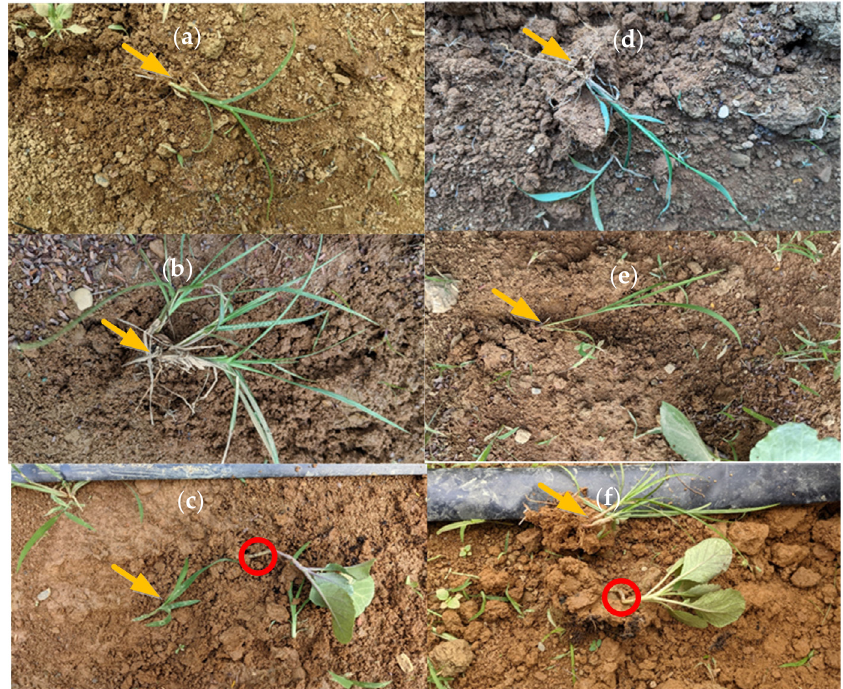
Figure 11. Snapshot of the soil on the field after weeding by the weeding machine. ( a ) weeds are completely removed by weeder #2, partially removed ( b ) and damaged crops ( c ); ( d ) weeds are completely removed by weeding tool #1, partially removed ( e ) and damaged crop ( f ). The red circle and orange arrow indicates the position of the crop roots and the root of the weed, respectively.